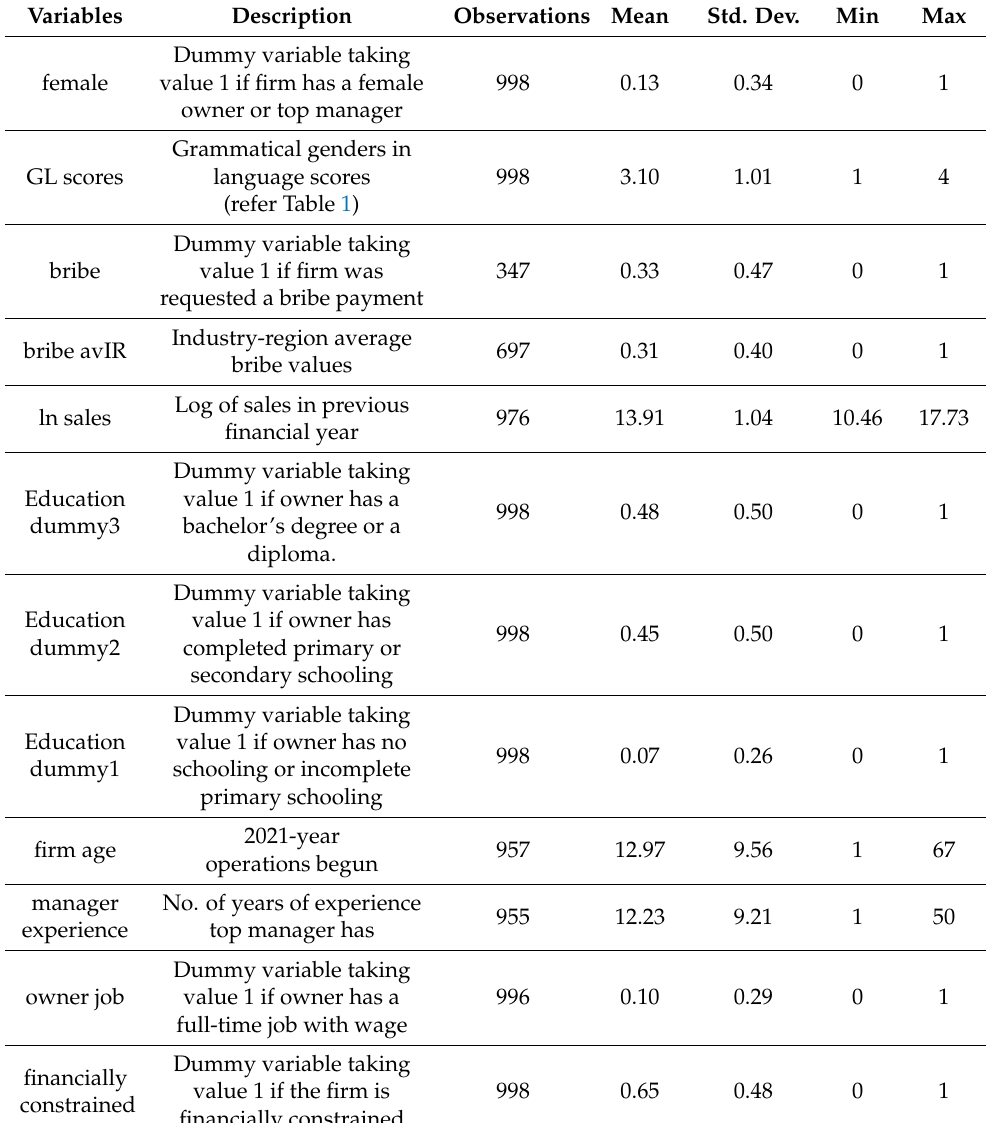
Table 2. Summary statistics and variable